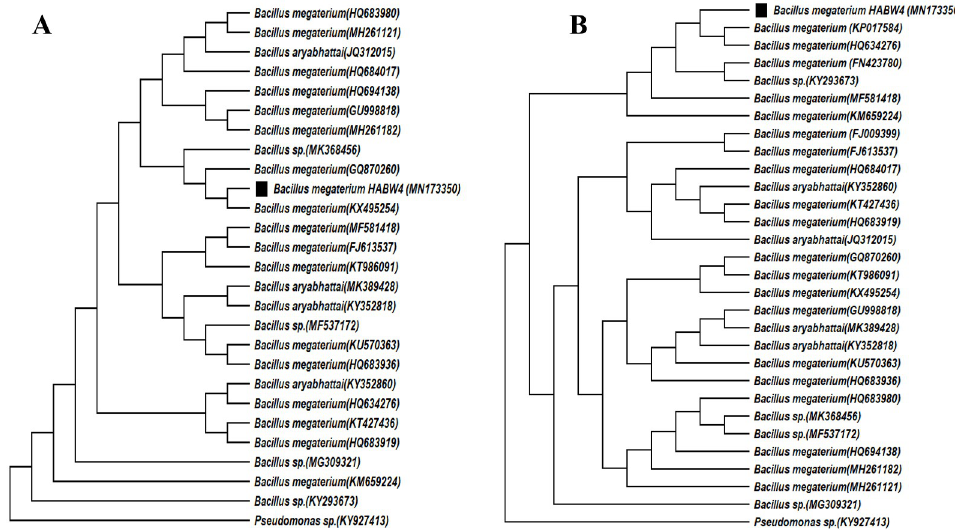
Fig 9. Phylogenetic tree (A: Neighbour-joining method, B: Maximum likelihood method) constructed based on 16S rRNA gene sequences of Bacillus megaterium HABW4 (MN173350) and other related sequences retrieved from NCBI.